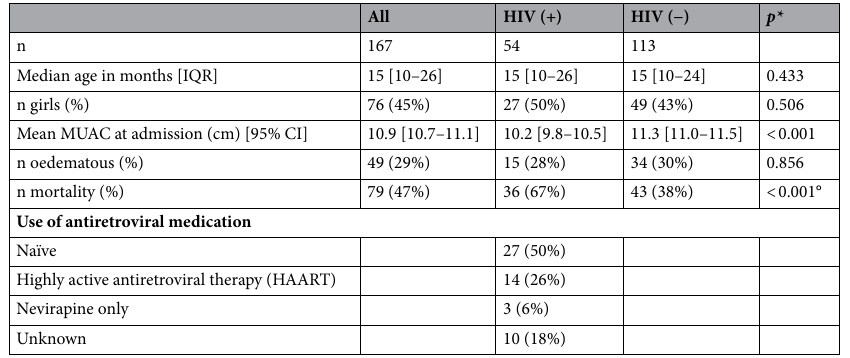
Table 2. Patient characteristics of those subjected to proteomics analysis. *Comparison between HIV(+) and HIV(−). °Adjusted for age, sex, site of recruitment, oedema.